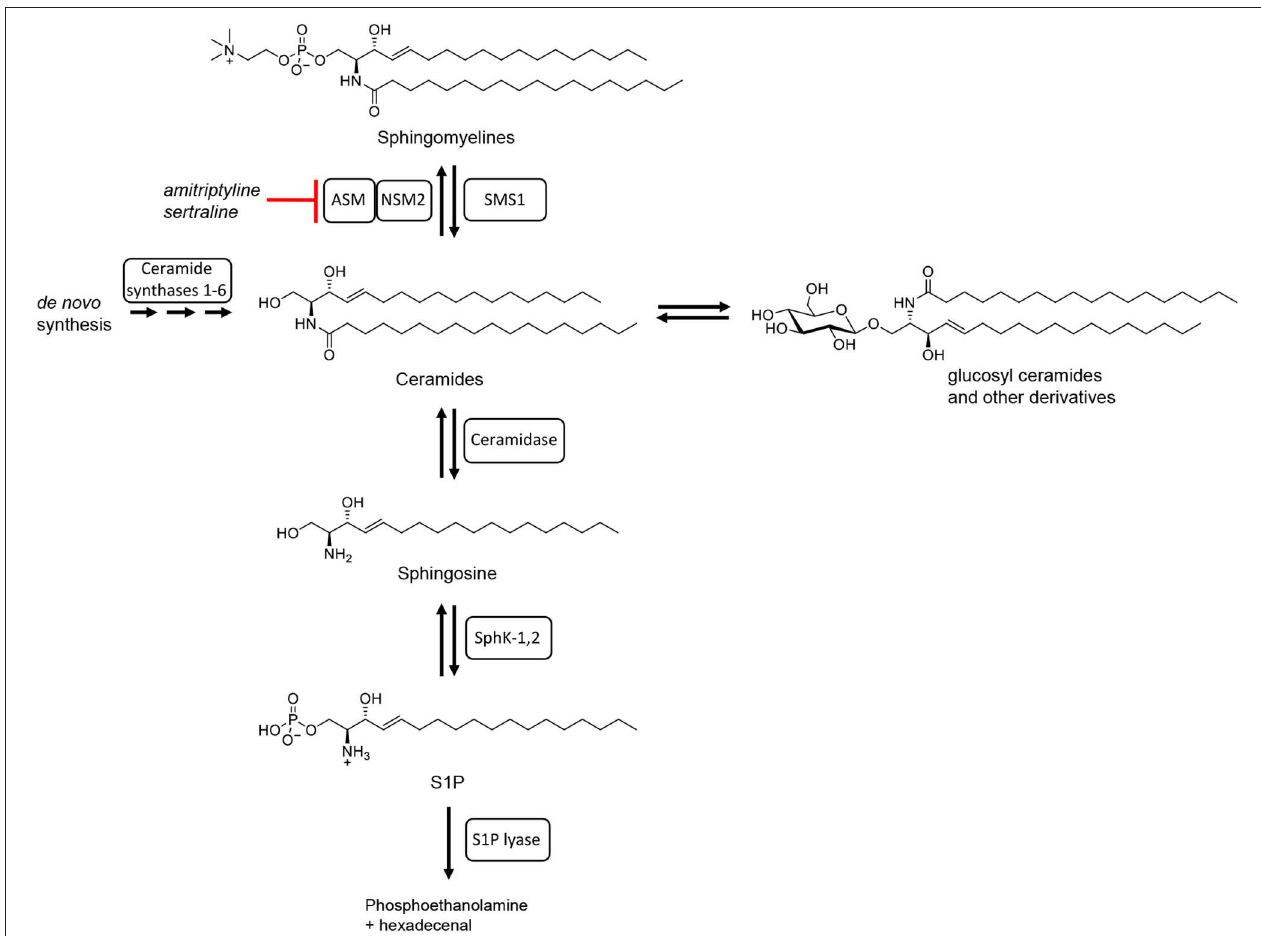
FIGURE 1 | Schematic summary of sphingolipid metabolism. Adapted from Bartke and Hannun (30) with chemical structures of the sphingolipids involved (all with C18 side